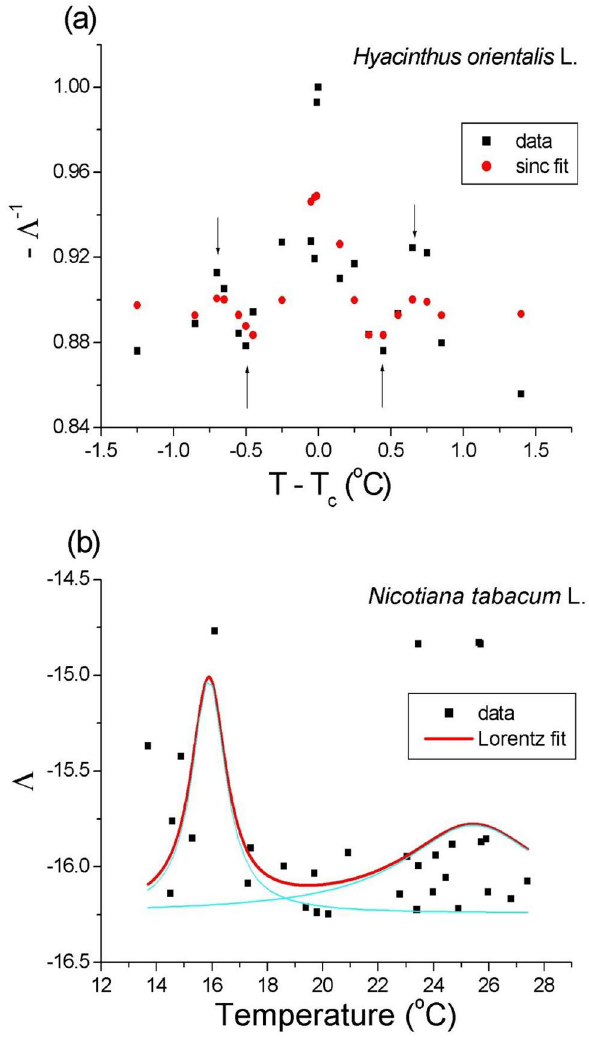
Figure 3. Dynamic range of the calculated dominant Lyapunov exponent (Λ, log scale) as a function of temperature for the hyacinth ( a ) and tobacco ( b ) pollen tubes at criticality. Fit parameters to the sinc function (red dots): R 2 = 0.51 ( χ 2 = 0.0005), baseline y 0 = 0.894(5), a = 0.05(1), and b = 11.27 ( 143 ) ; T c ∼= 22.85 °C. (b) Two critical regions were indicated by the maxima of the multi-peak Lorentz resonance curve: germination at 15.89(45) °C and optimum at 25.44(193) °C. Data points (solid squares) from the experimental time series (each point represents 5000 measurements) were calculated in R